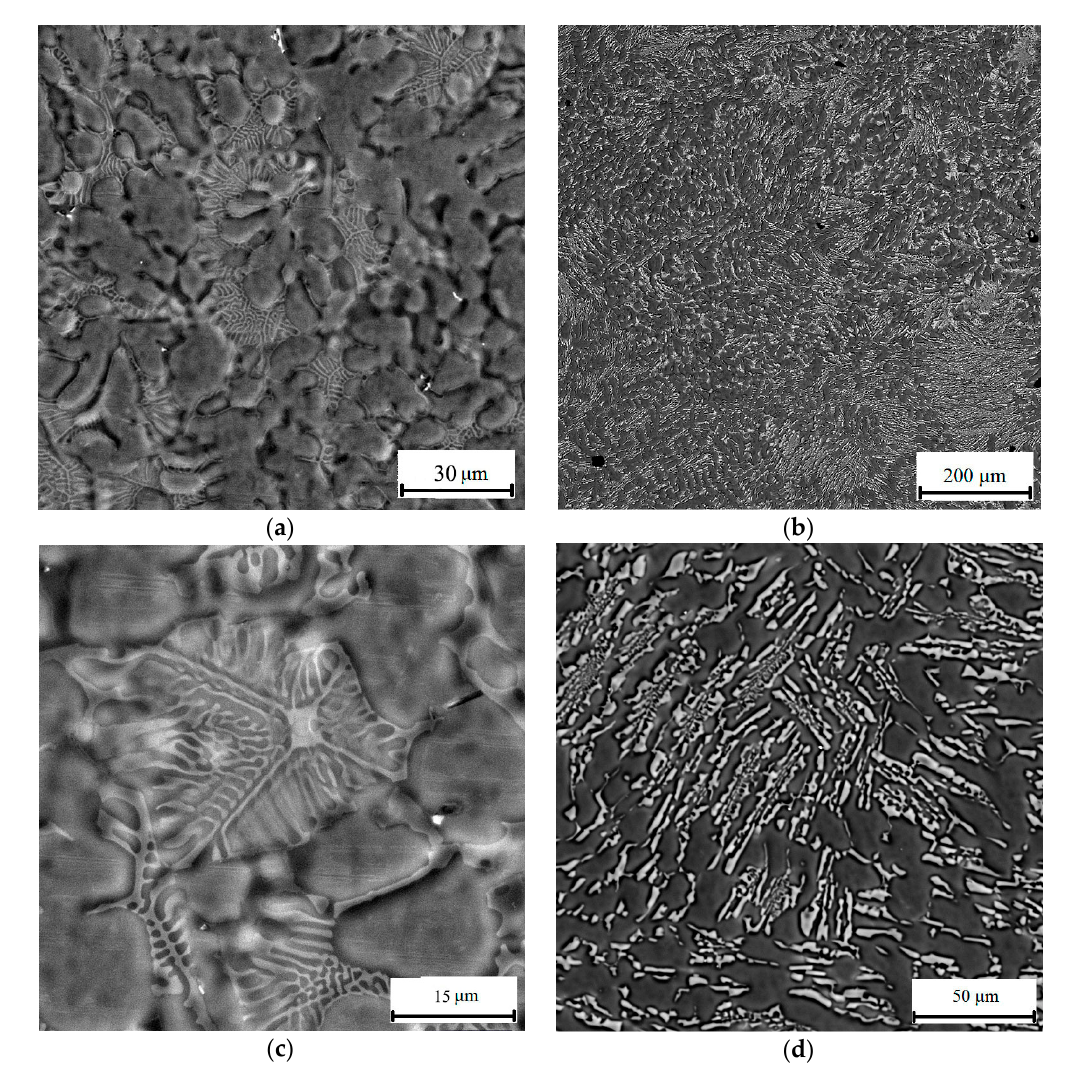
Figure 5. Microstructure of near-eutectic ternary alloys Al4Ca12Mg ( a , c ); and Al6Ca2.5Mg ( b , d ), scanning electron microscope (SEM) (Backscattered electrons (BSE)).